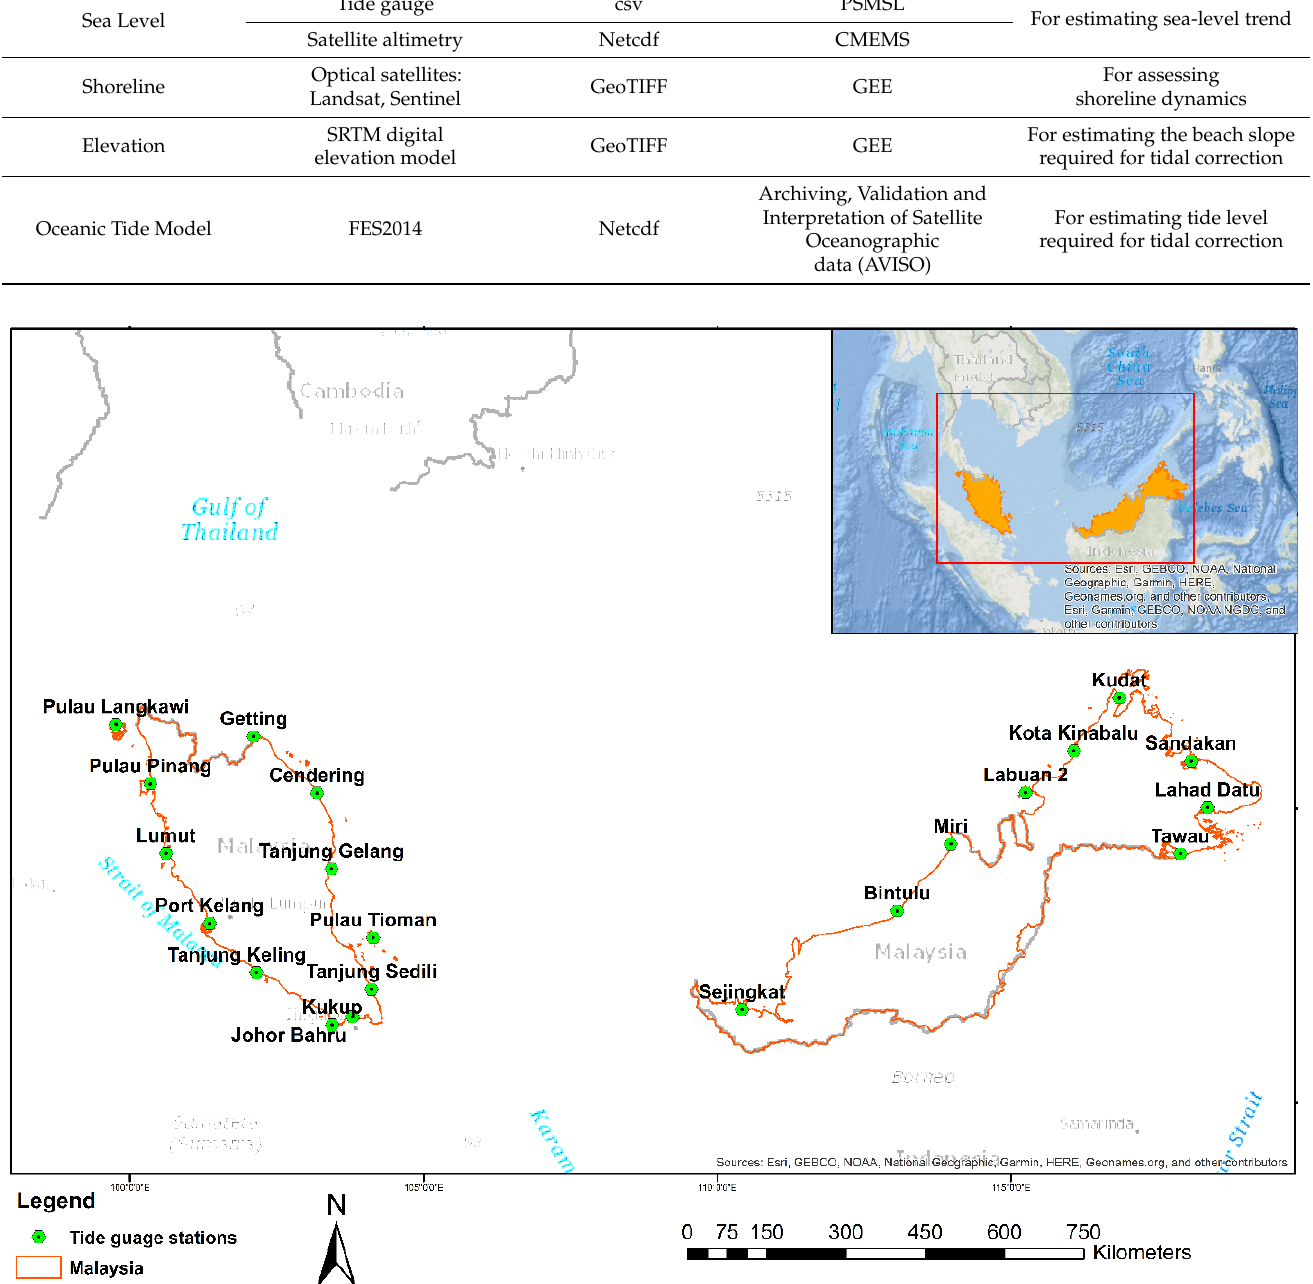
Figure 1. Map of study area showing the tide gauge stations.